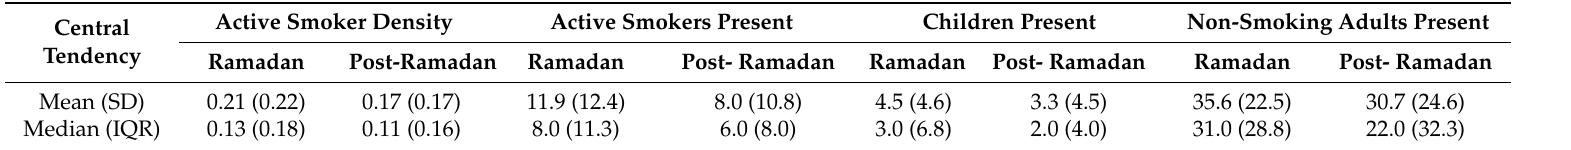
Table 1. Smoking behavior in 43 smoking venues, Jakarta